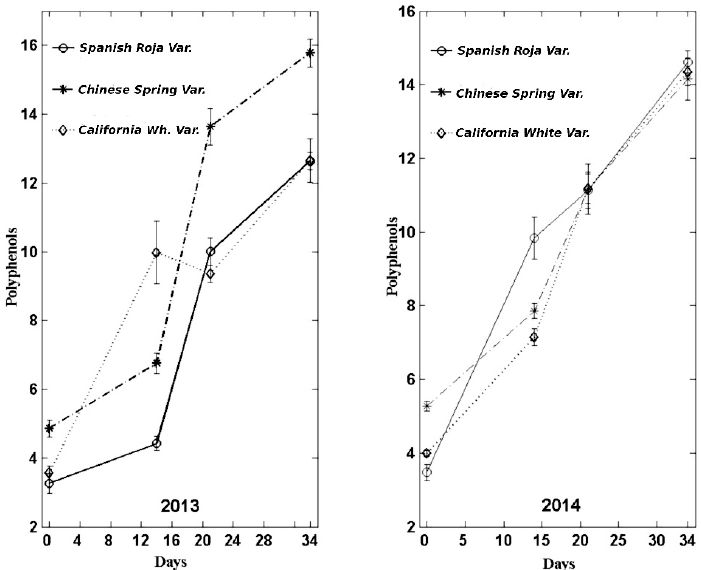
Figure 5. Evolution of the polyphenol content (g Gallic / Kg lyophilized sample) during the manufacture of black garlic with three varieties and two types of garlic: one-year-old and recently harvested.